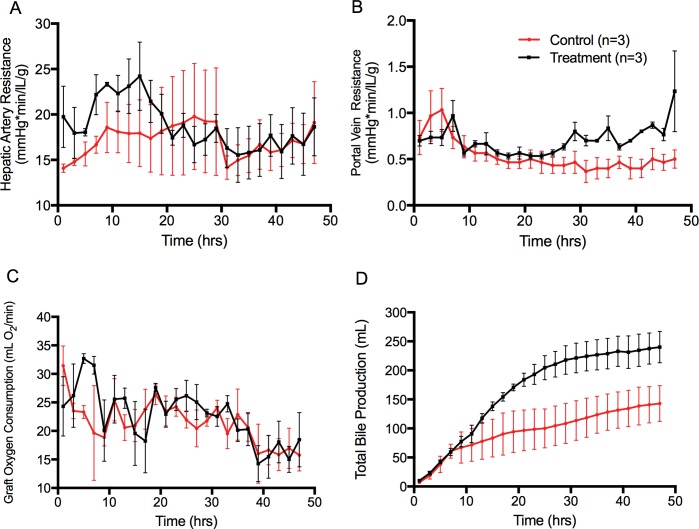
Vascular parameters and bile production during NMP.(A) Hepatic oxygen consumption during NMP (p = 0.41). (B) Total bile output during NMP (p<0.0001). (C) Hepatic artery resistance during NMP (p = 0.14). (D) Portal vein resistance during NMP (p = 0.0003). Data points show means and SEM, 95% confidence interval. Normothermic machine perfusion (NMP).